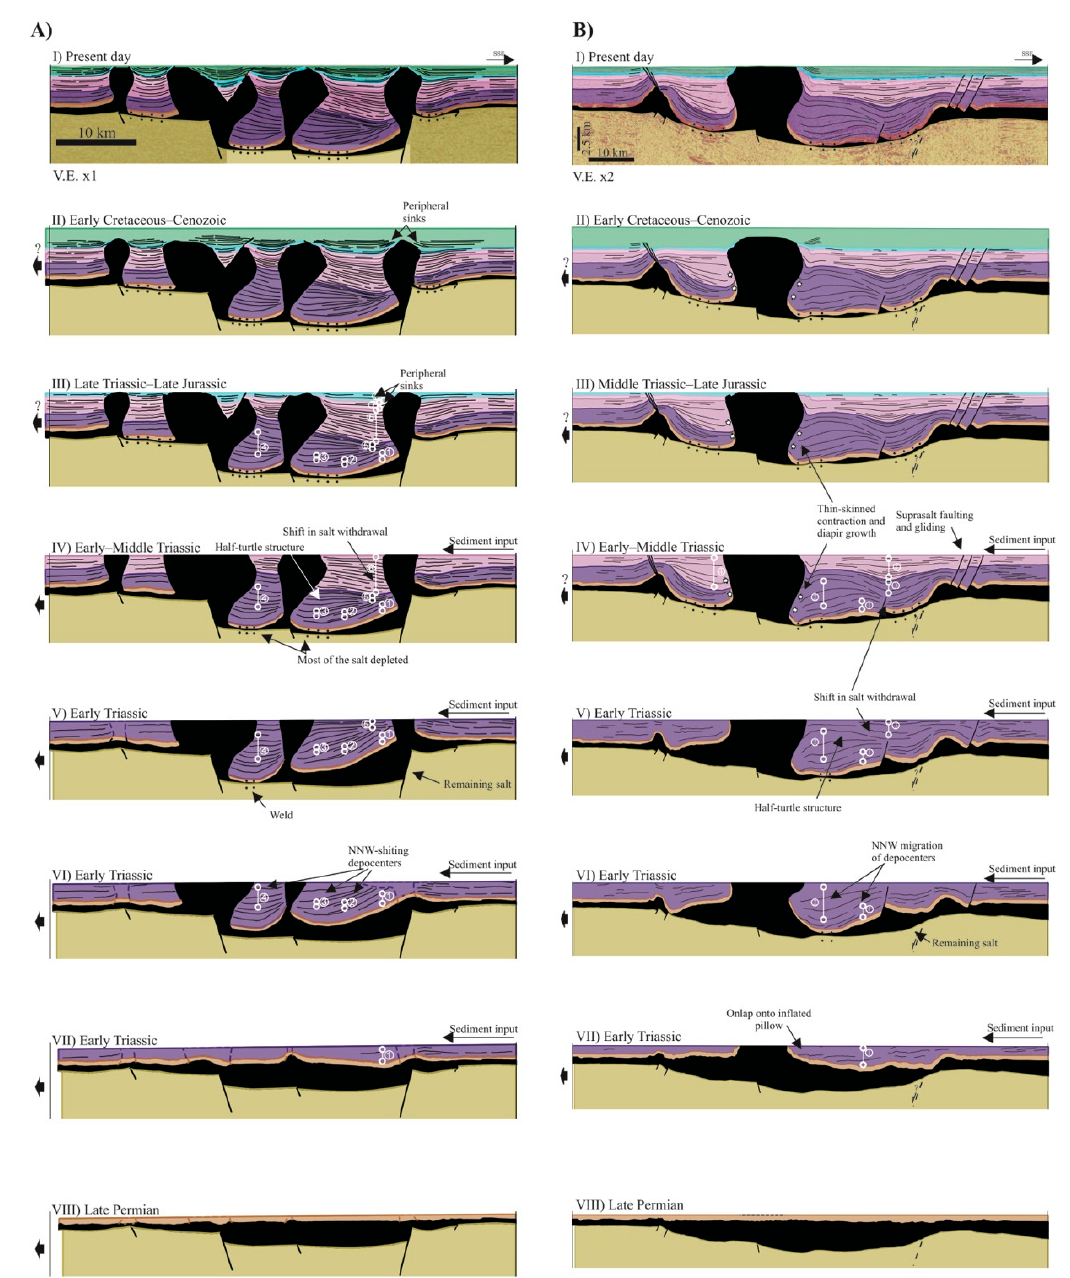
Figure 4. ( A ) Structural restoration of section A (Figure 2B) in the central sub-basin. ( B )